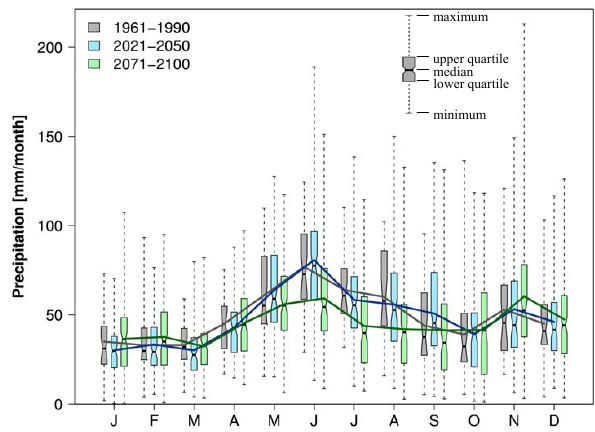
Fig. 4. Box diagrams of the simulated monthly precipitation (mm/month) area-averaged over Hungary for 2021–2050 (blue) and 2071–2100 (green) and the observations (CRU, grey) for the period of 1961–1990. The future precipitation amounts are calculated by adding the simulated relative changes to the reference mean observed in 1961–1990. Curves are indicating 30-year average values, while lower and upper whiskers of the plot represent the minimum and maximum of the time-series of the given month.